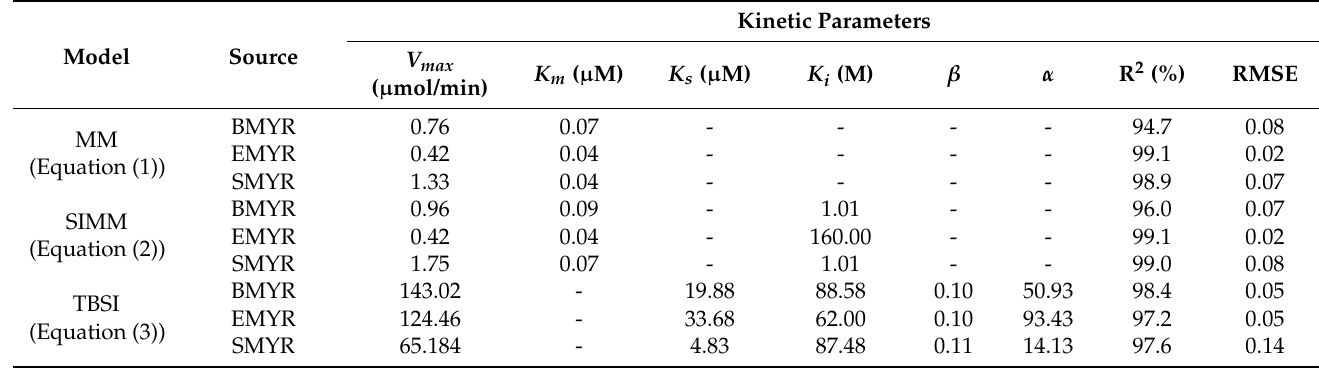
Table 1. Estimation of kinetic parameters of